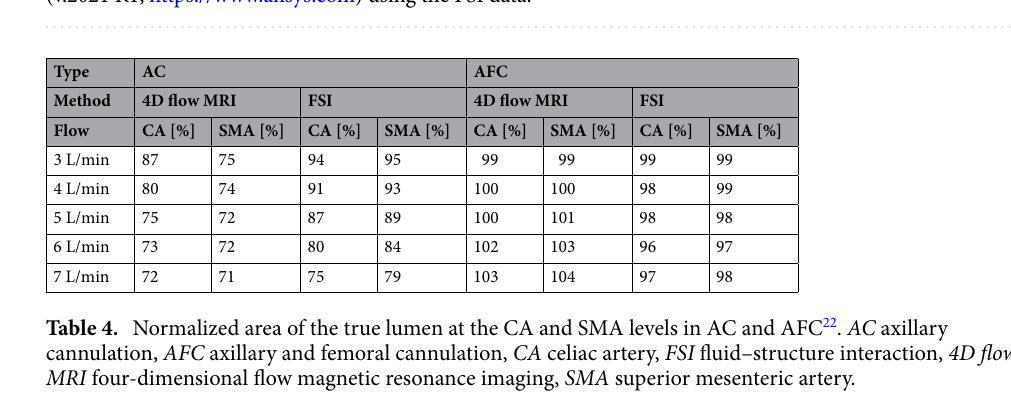
Figure 6. Normalized true lumen area of CA and SMA for AC and AFC. These images were made with Ensight (v.2021 R1, https:// www. ansys. com) using the FSI data.